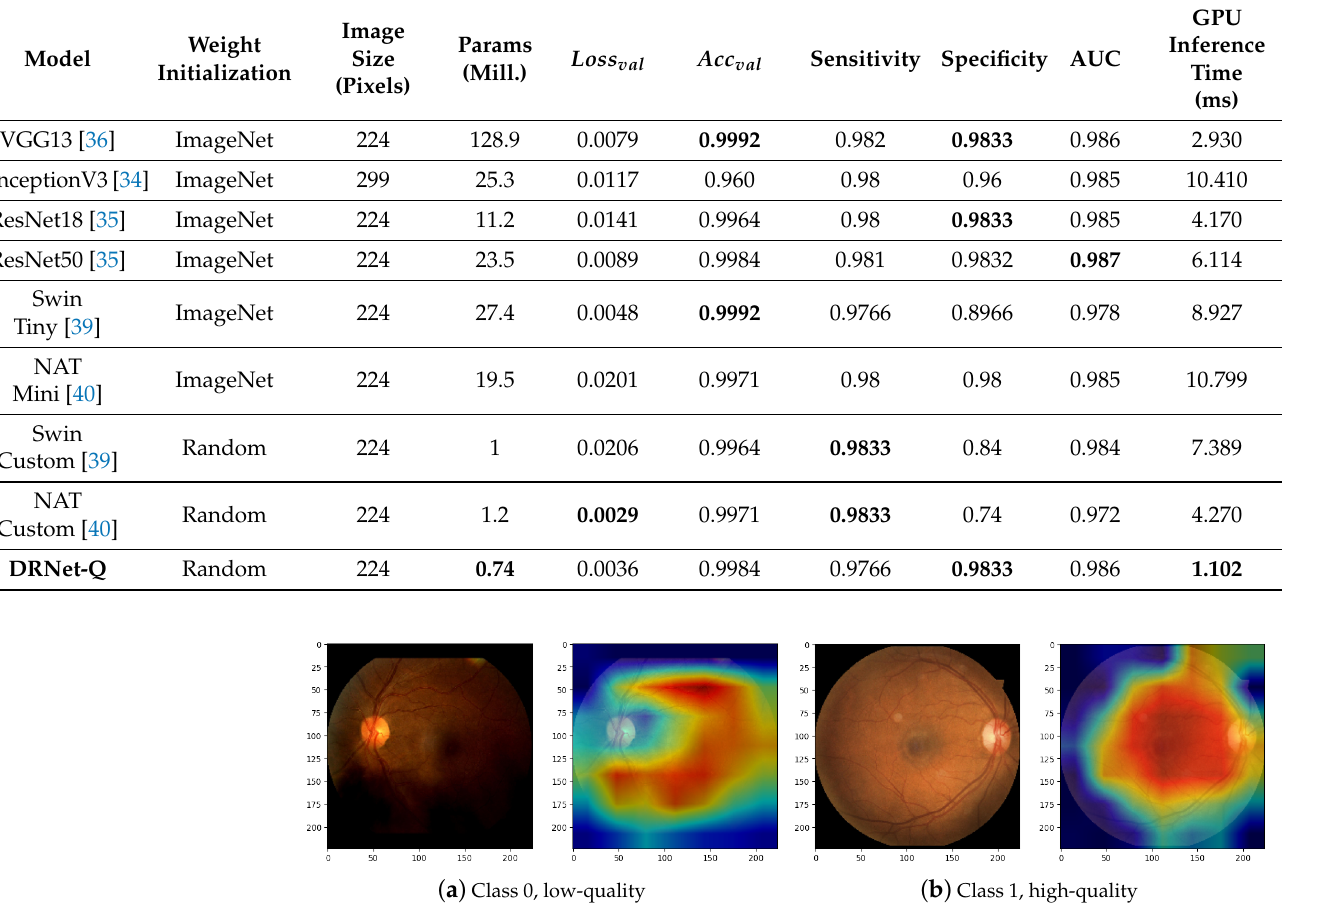
Figure 11. Gradient map visualization for quality classification. Class 0 ( a ) corresponds to the low-quality classification according to DRNet-Q, and Class 1 ( b ) is the high-quality classification according to the CNN model.